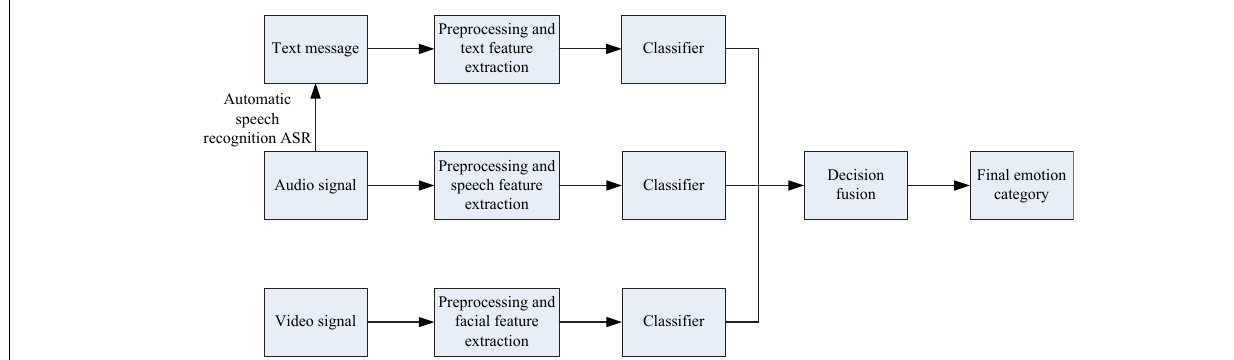
FIGURE 3 | Flow chart of decision-making level fusion.